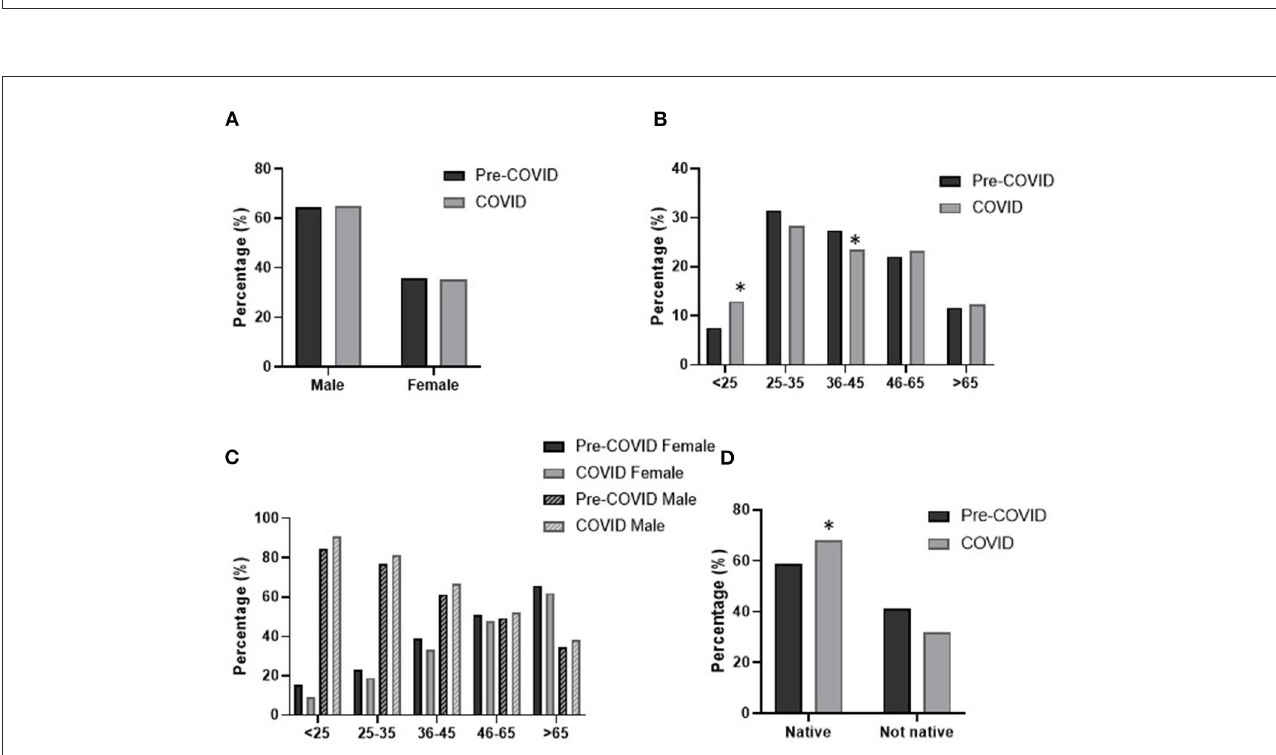
FIGURE2 Patient profile across pre-pandemic and pandemic periods. Distribution of participants by (A) sex, (B) age, (C) age and sex and (D) origin. Statistical differences: * p < 0.05 pandemic vs. pre-pandemic.